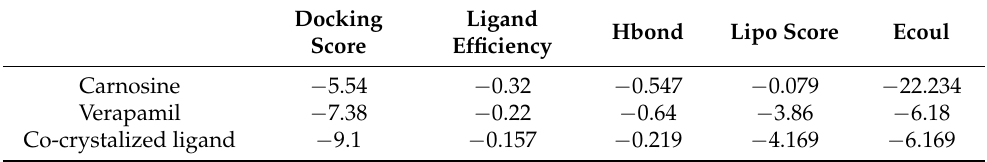
Table 1. The docking score and binding properties of carnosine, verapamil, and the co-crystalized ligand. Docking Score